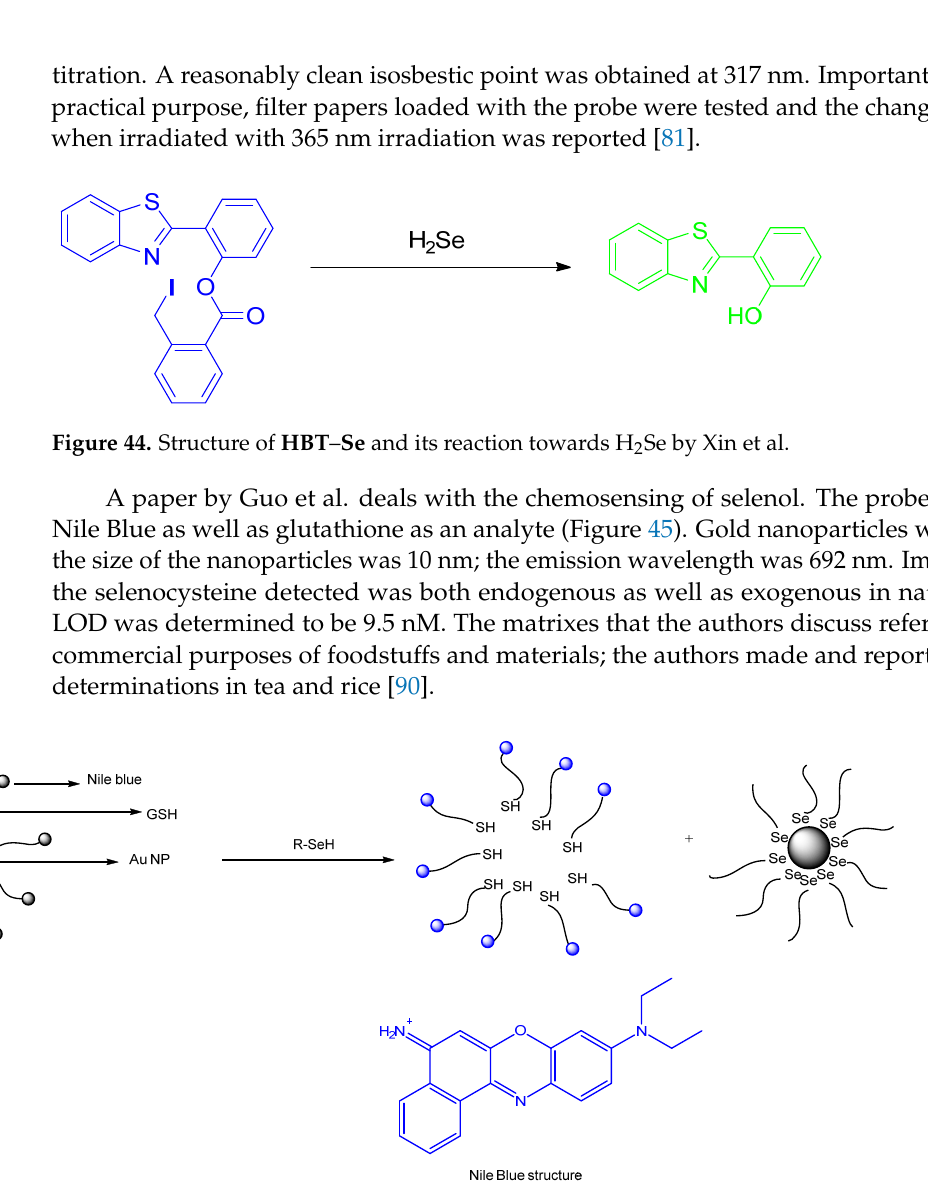
Figure 45. Detection of selenol compound with gold nanoparticles and Nile Blue by Guo et al. Hu et al. designed a NIR fluorescence probe based on a 13 nm diameter gold nano-